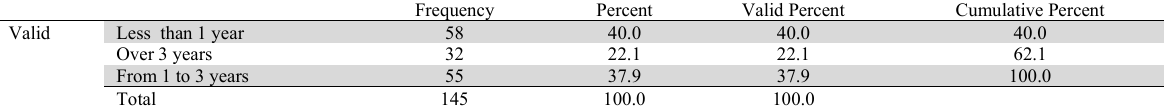
Respondents by work experience